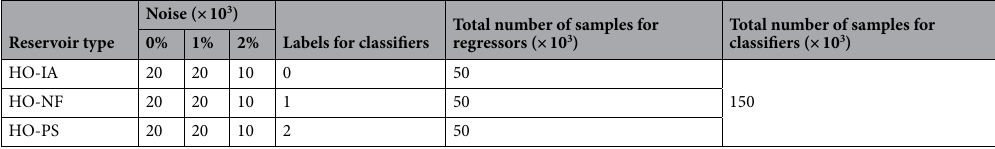
Table 1. Details of noise and number of samples used for classifiers and regressors.